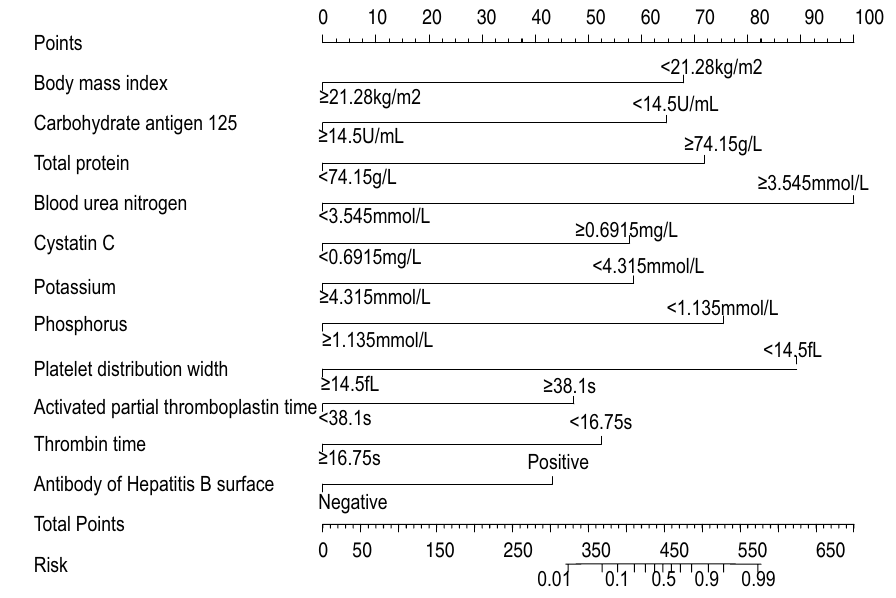
Figure 2. Nomogram to predict breast pathologic complete response rate of breast cancer patients after neoadjuvant chemotherapy based on clinicopathological characteristics and serological indices.